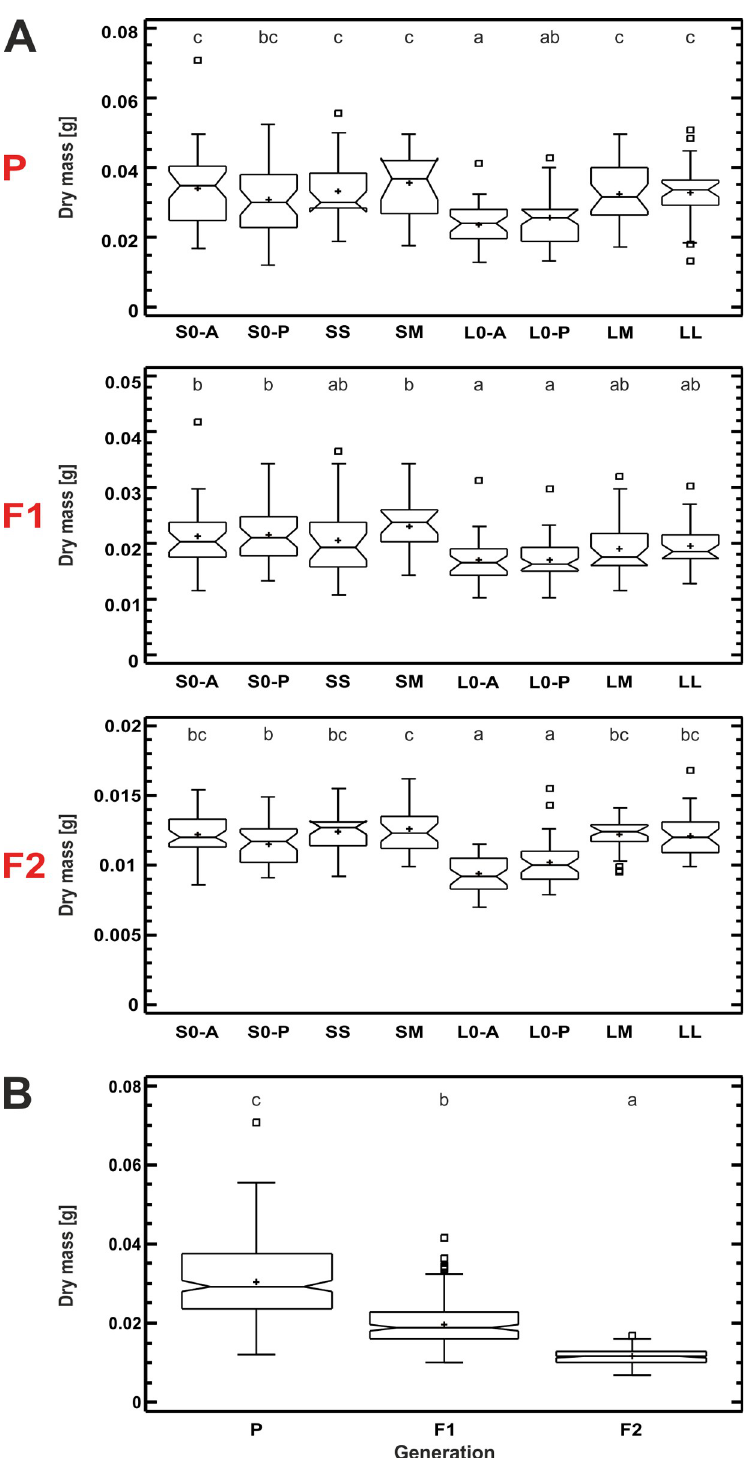
Fig 5. Dry body mass in the three generations of Poecilus cupreus from all experimental groups, representing different habitat types and treatments (A) and across all generations (B). The first character stands for landscape type: S–small fields landscape, L–large fields landscape; the second character stands for canola coverage: 0 –none, S–small (10–14%), M–medium (20–52%), L–large (80–98%). Within each generation all groups except those marked with letter “A” were exposed to Proteus 110 OD insecticide. Red uppercase letters indicate generations: P–parental, F1 & F2